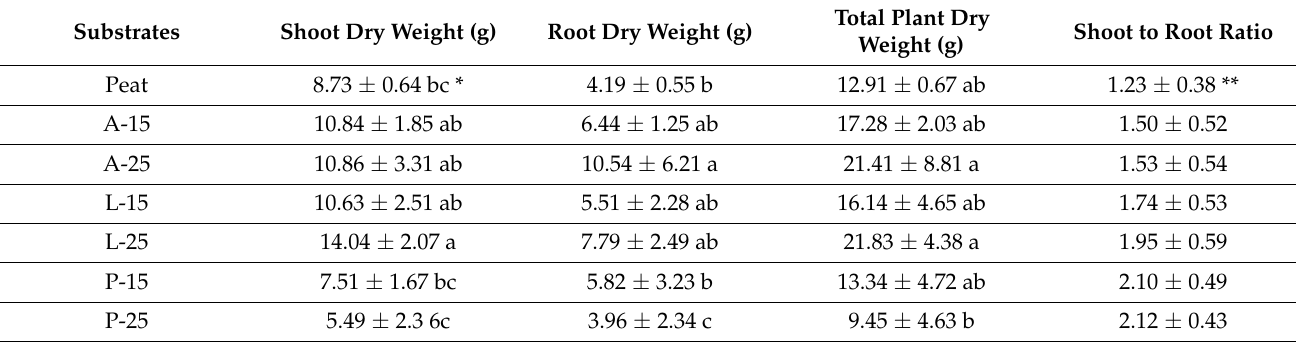
Table 9. Dry matter distribution in strawberry cv. ‘Honeoye’ cultivated in different substrates (mean ± SD).